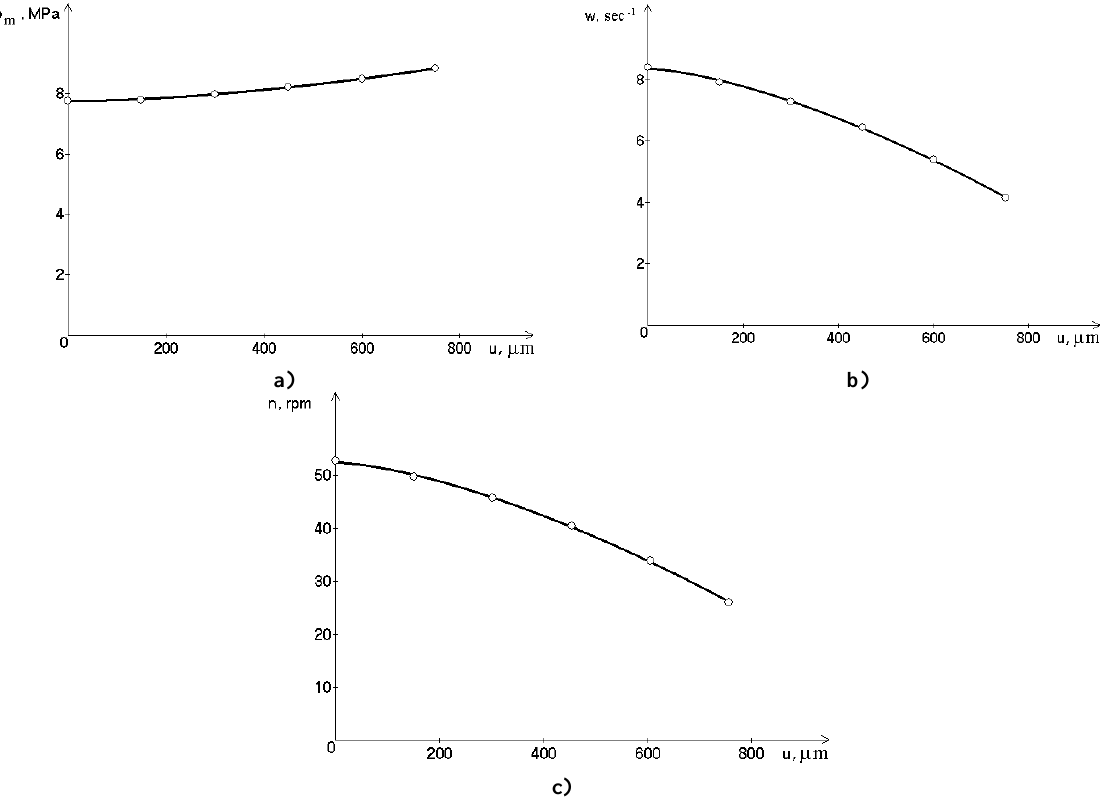
Fig. 3. Dependences of nominal values of pressures at the inlet of the hydraulic motor (а), angular velocity (b) the speed of rotation (c) of the auger from the values of its wear: actual ○, theoretical —